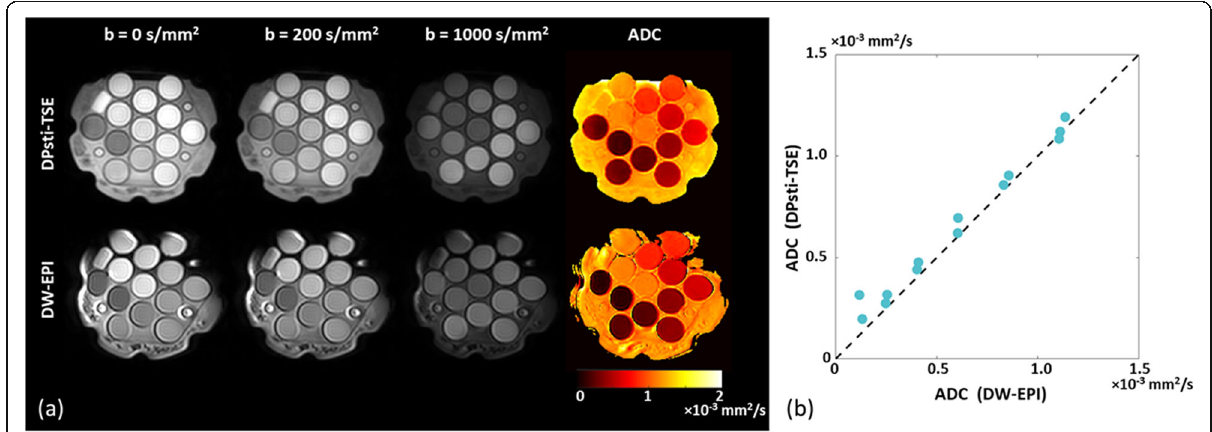
Fig. 5 Diffusion phantom measurement. a DWI images and ADC maps for the diffusion phantom obtained using DPsti-TSE and DW-EPI methods. b The comparison of ADC mean values obtained from DPsti-TSE and DW-EPI for 13 tubes contained in the phantom. Identity line (45° line) was plotted for reference. ( ADC apparent diffusion coefficient, DPsti-TSE diffusion-prepared stimulated echo turbo spin-echo, DW-EPI diffusion- weighted echo-planar imaging)